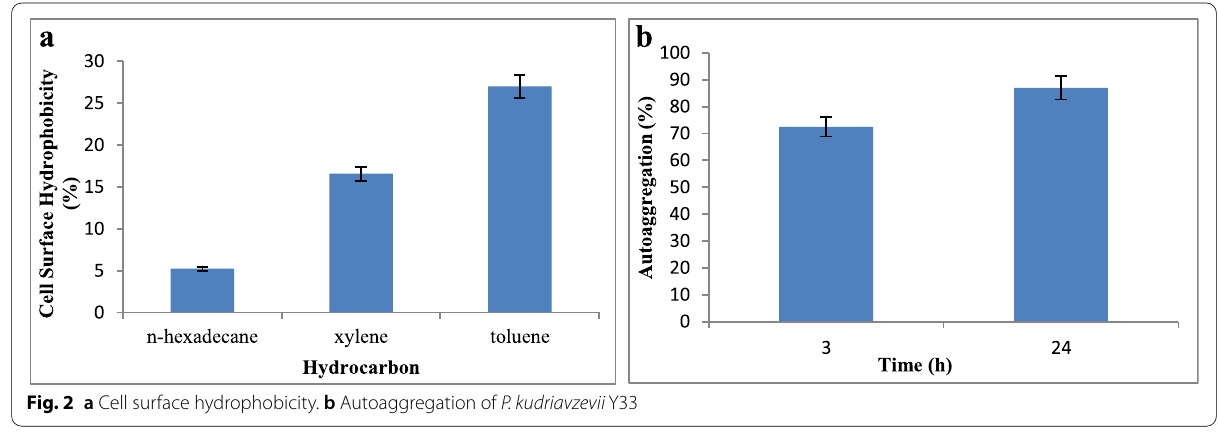
Fig. 2 a Cell surface hydrophobicity. b Autoaggregation of P. kudriavzevii Y33